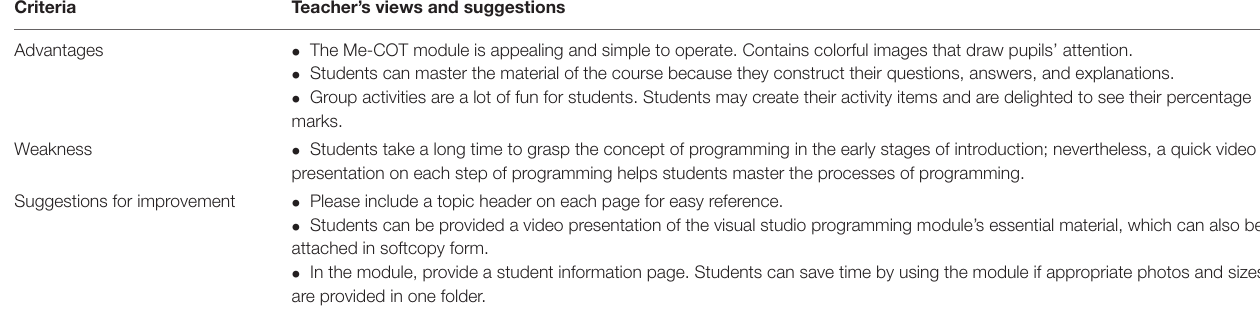
TABLE 9 | Teacher’s views and suggestions. Criteria Teacher’s views and